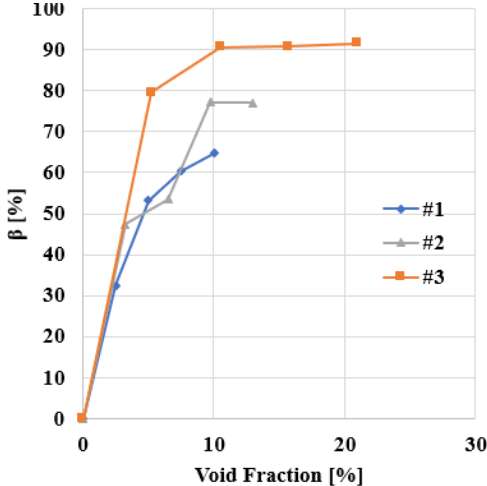
Figure 12. Changes of 𝛽 with void %.